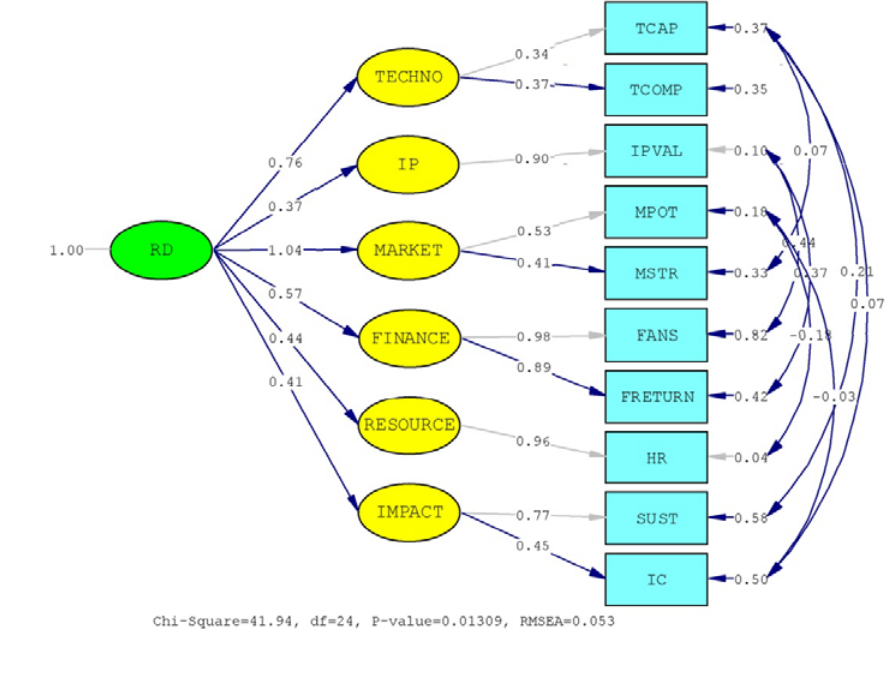
Fig. 2. Hierarchical model (path